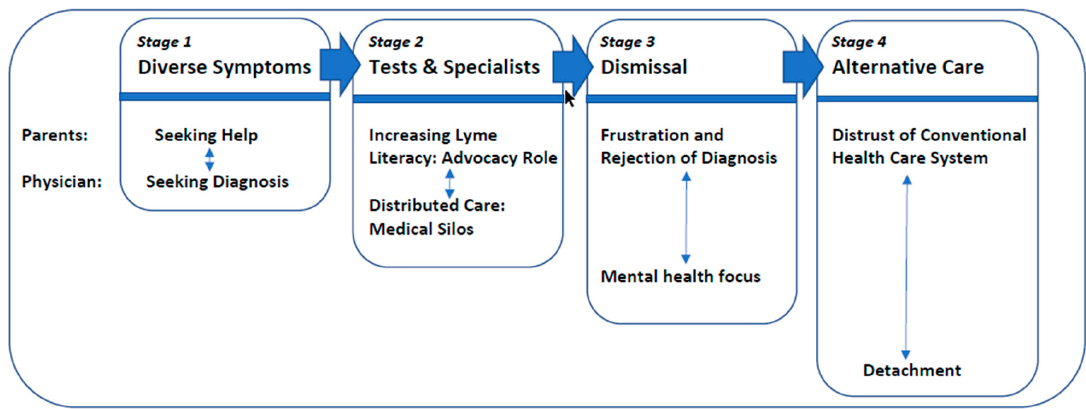
Figure 1. Parents’ perception of children’s Lyme disease care experiences.